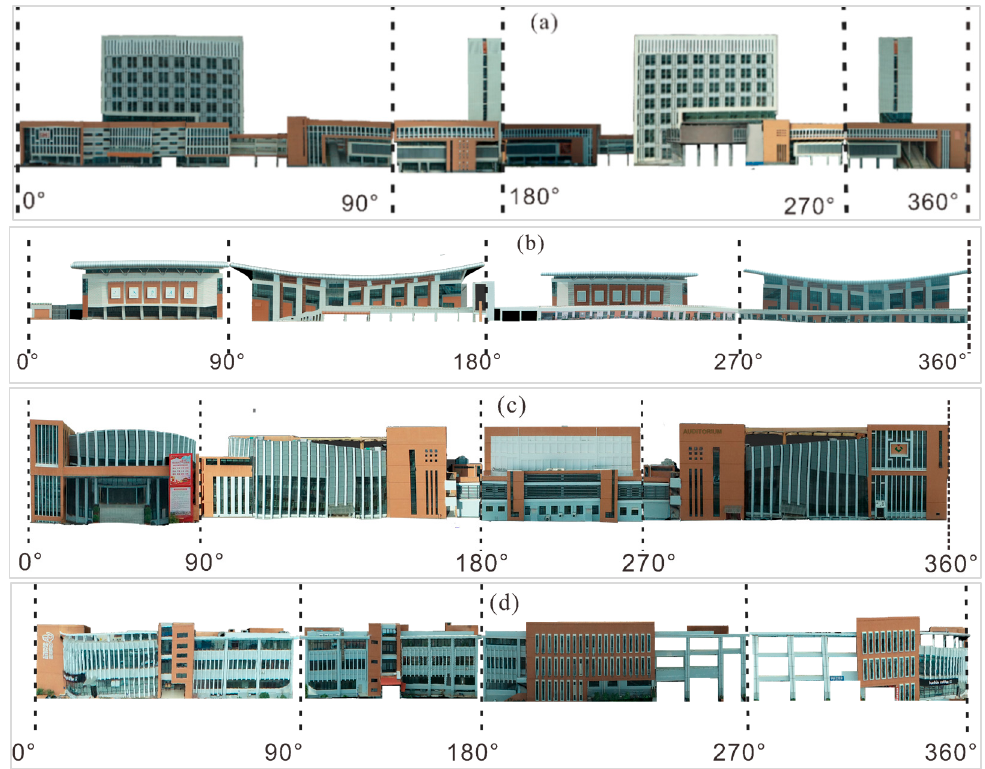
Figure 18. Façade texture orthorectification results. ( a – d ) are the orthorectification results of the building Façade texture in ( a – d ) in Figure 17.